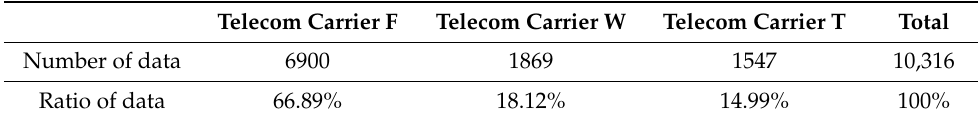
Table 1. The dataset among three telecom